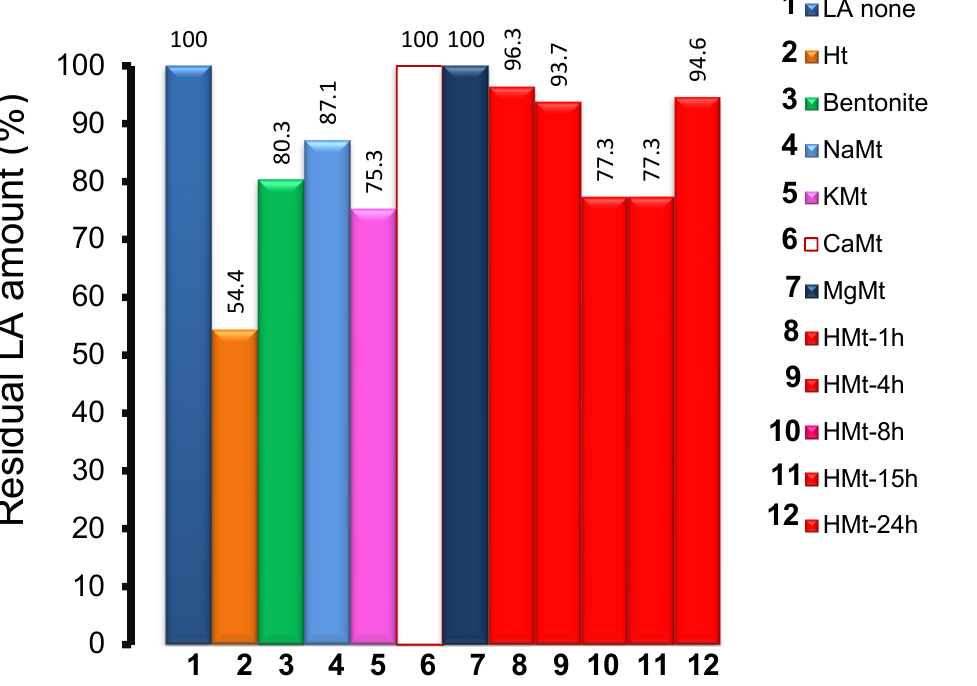
Figure 2. LA residual amount (%) in aqueous clay suspensions before ozonation as assessed by HPLC-UV in the centrifuged supernatant after 3 min contact with the respective clay mineral. Clay impregnation was achieved by mixing 4 mg of cationic clay minerals with 20 mL LA aqueous solution with a concentration of 2.5 g L − 1 (27.75 mM) under manual stirring for 3 min. Ht was impregnated according to the same procedure but with 2 h stirring. The sample was then centrifuged and filtered with a 0.22 µm filter.